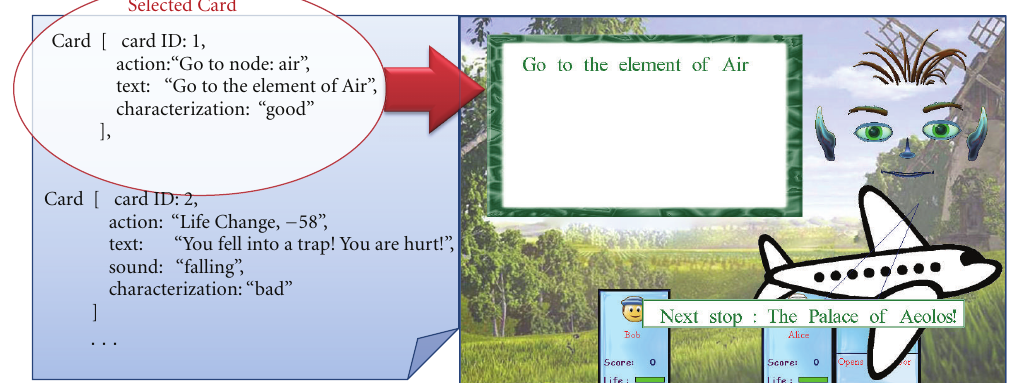
Figure 14: An example of the card-draw game. On the left, we display part of the configuration file that contains all cards. In this example, the random choice yields the first